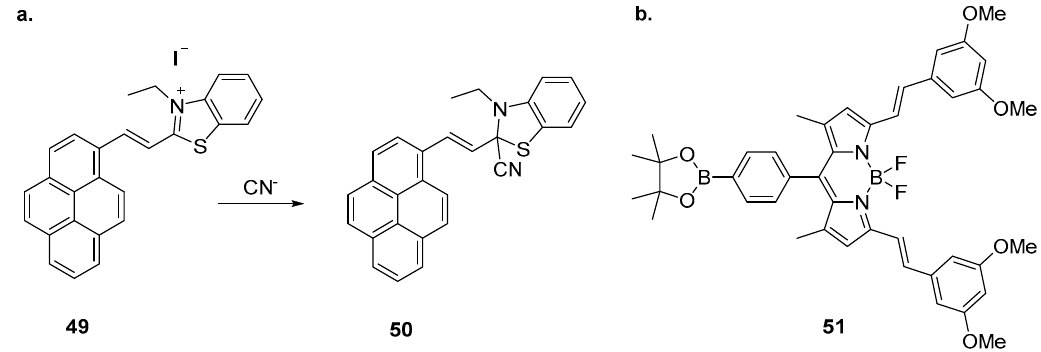
Figure 21. Non-macrocyclic fluorescent probes for anions. ( a ) Pyrene-based 49 is an effective sensor for CN − anion, which reacts with the central carbon of the benzothiazolium component to form the emissive species 50 [123]; ( b ) BODIPY-functionalised boronate ester 51 responds to both CN − and F − , even in the presence of various other competing anions. F − triggers quenching and a blue shift in the emission of 51 from 599 nm to 579 nm, and new bands at 509 nm and 639 nm; CN − also brings quenching and a blue shift to 575 nm, plus a single new emission at 478 nm [124].